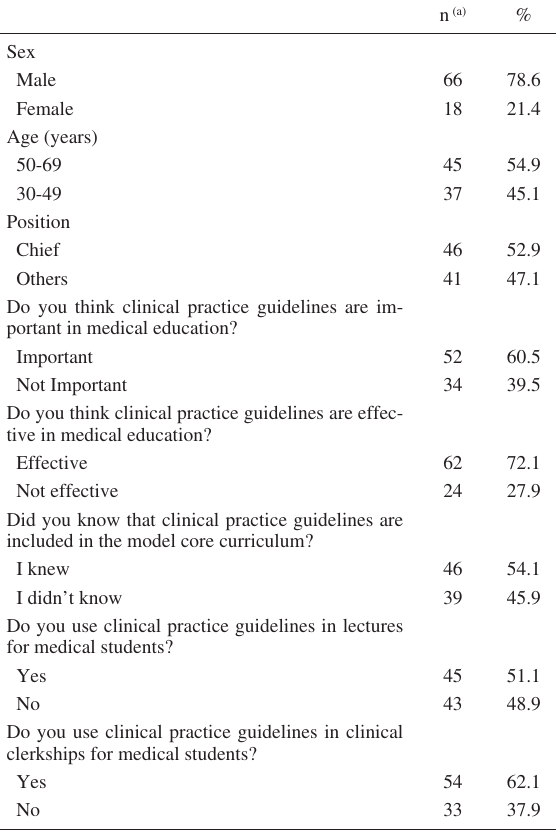
Table 1. Demographic characteristics and recognition of clini- cal practice guidelines among doctors (n = 89, 72.4%).